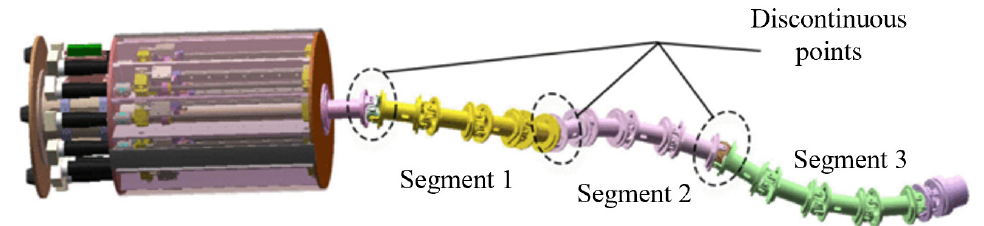
Figure 1. Structure diagram of the